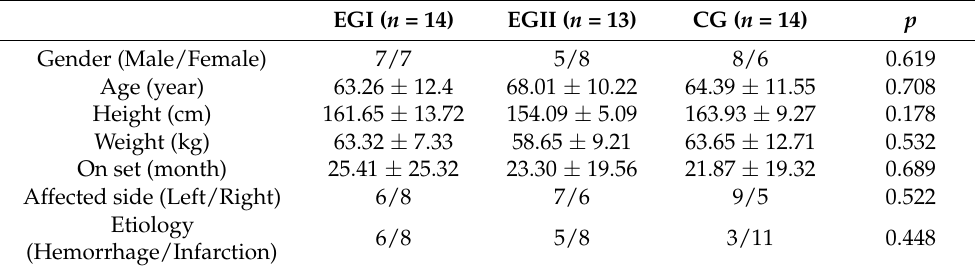
Table 1. General characteristics of subjects.